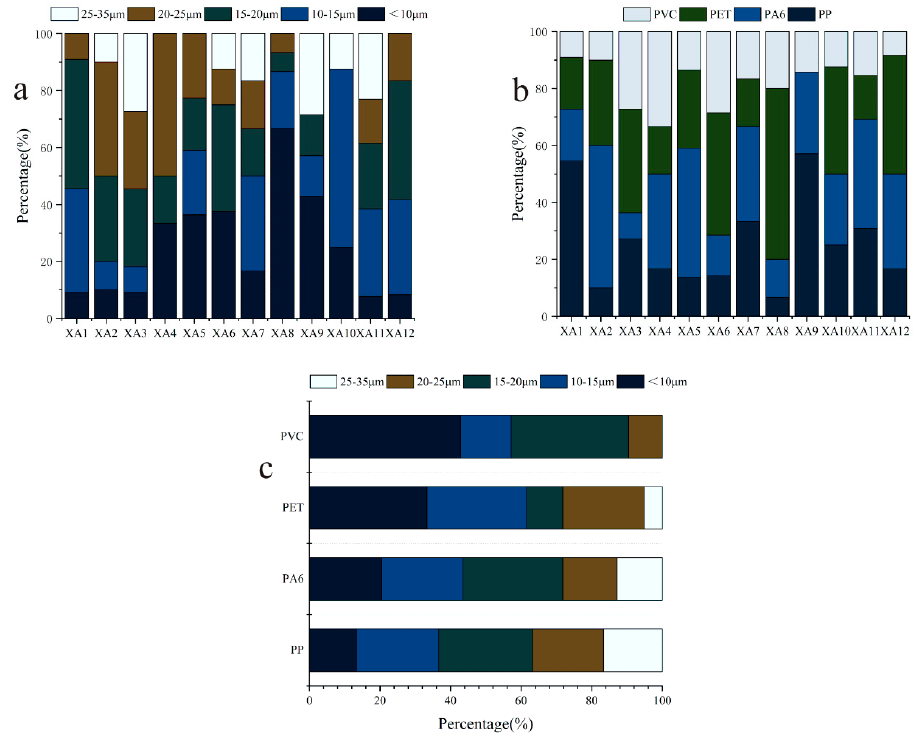
Figure 4. Particle size, type and abundance of MPs in soil. ( a ) Particle size composition and relative content of MPs in soil; ( b ) Composition and relative content of MPs types in soils; ( c ) Particle size composition of di ff erent types of MPs in the soil.